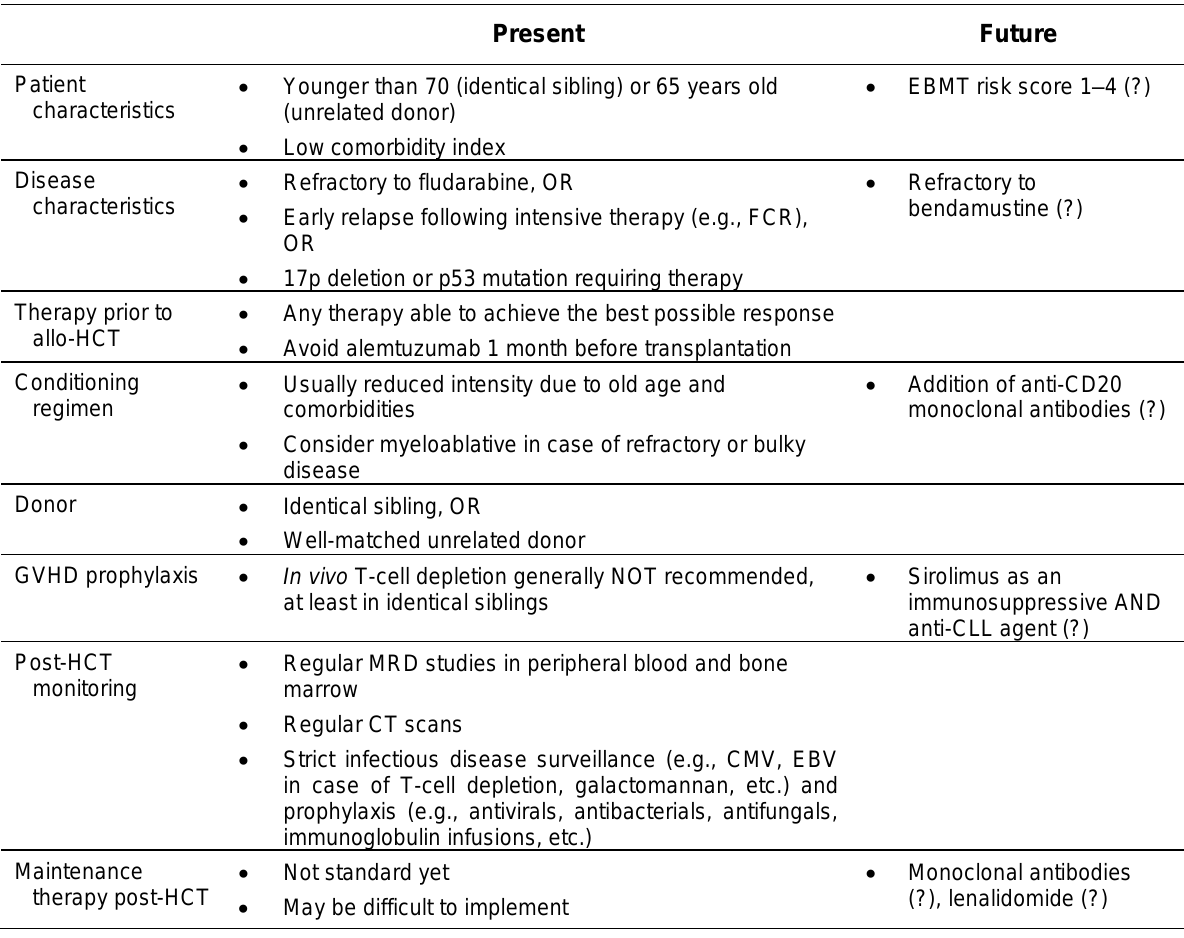
Allo-HCT for CLL in 2011 and Beyond: a Personal View Present